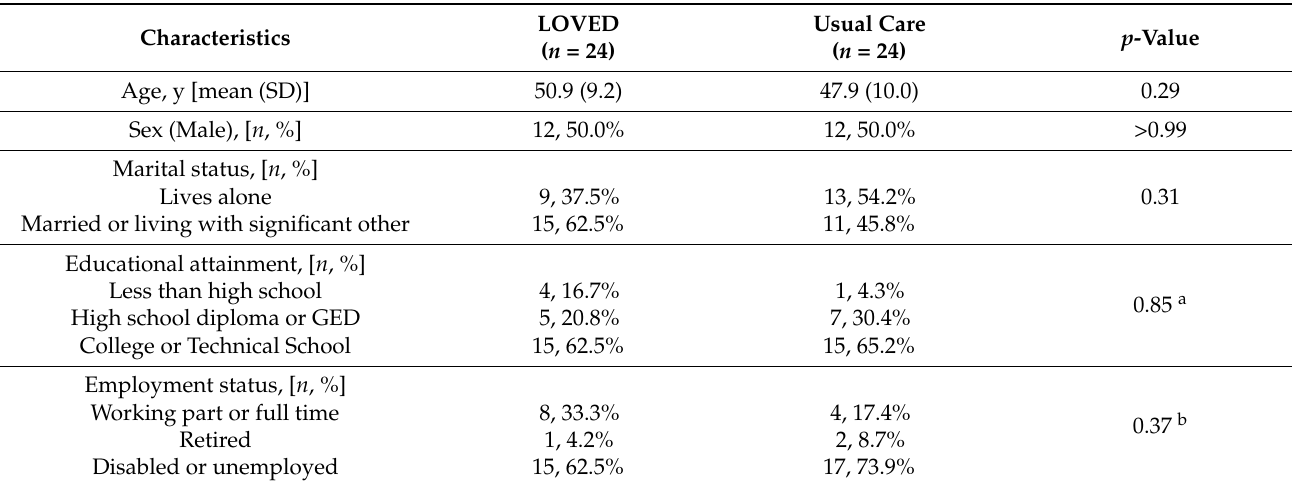
Figure 1. Participant flow chart. Table 2. Demographic characteristics.